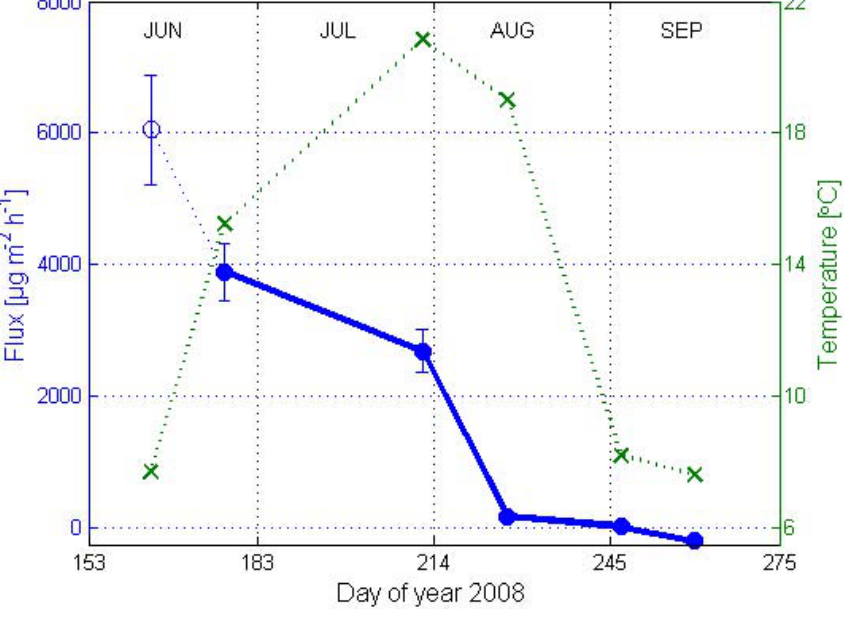
Fig. 3. Daily mean fluxes of monoterpenes (blue solid line) and corresponding air temperatures (dotted green line). Error bars of the fluxes are the standard errors of the means. The data of 13 June were discarded from further analyses due to corrupted wind measurement and are shown here by open